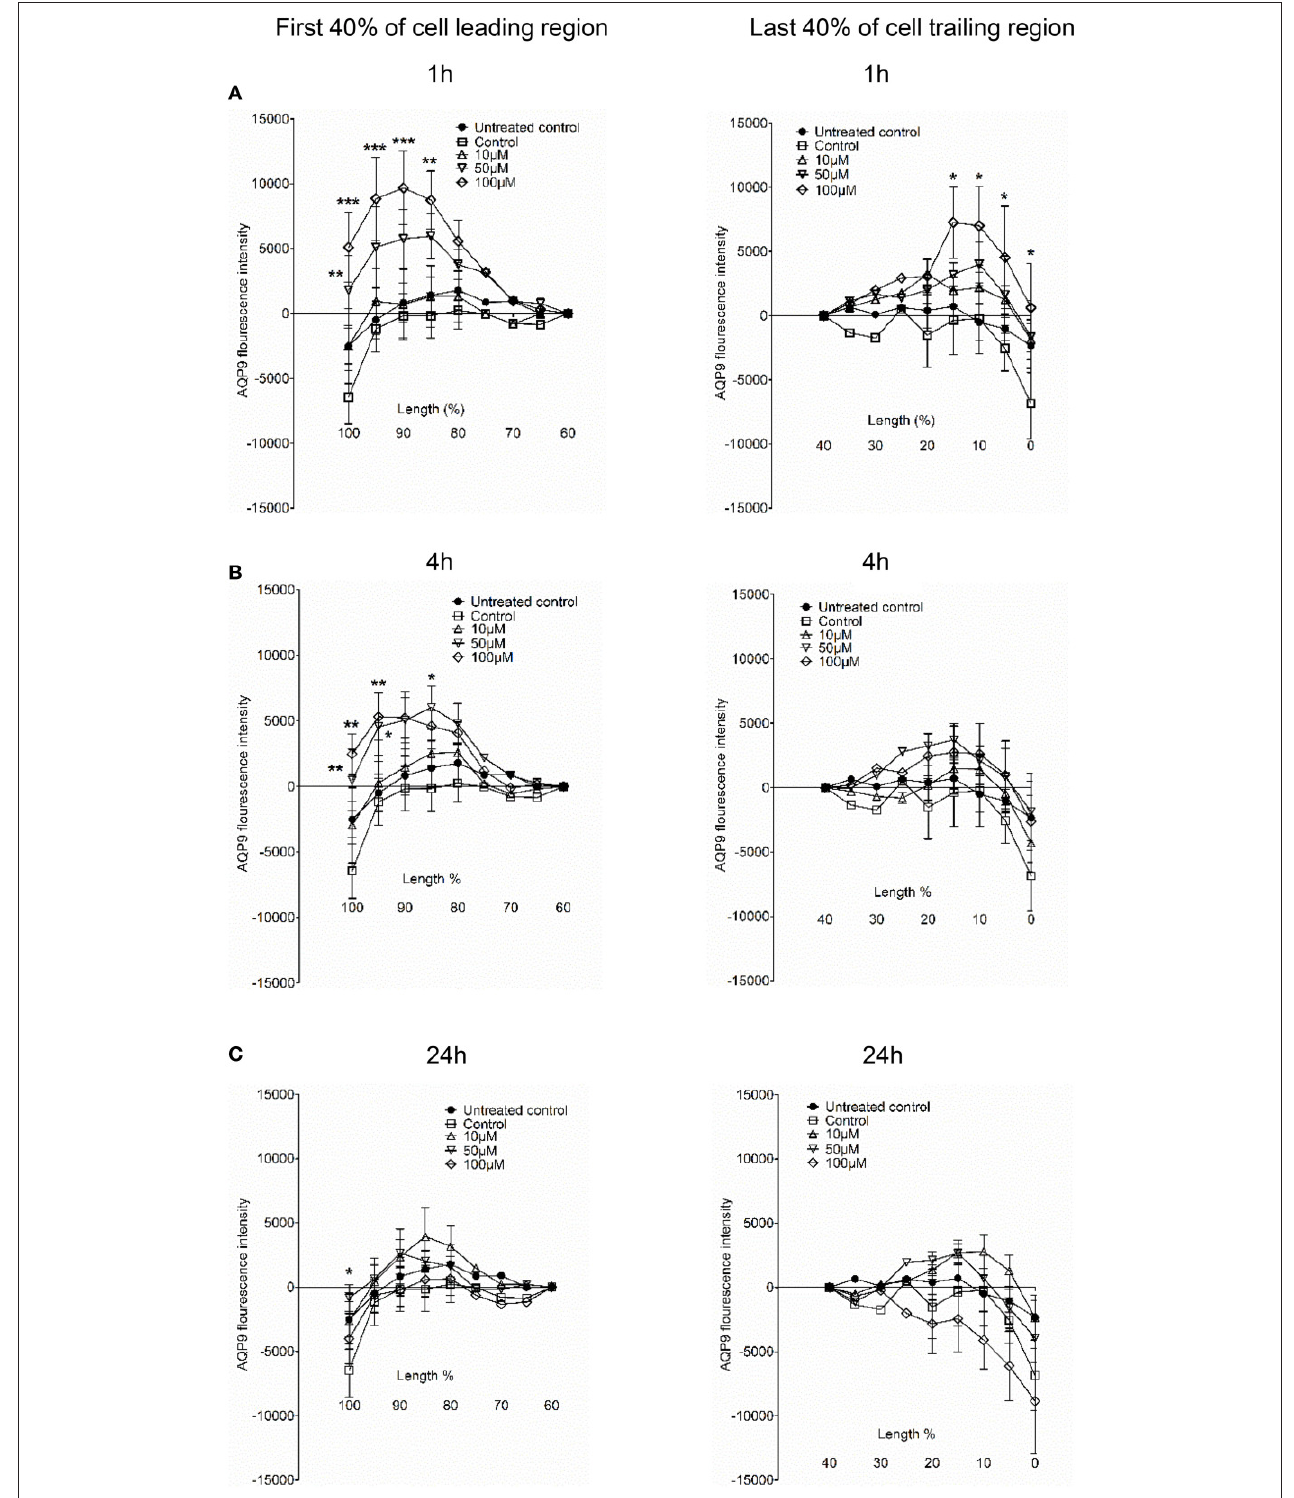
FIGURE 5 | AQP9 intensity profiles across the leading and trailing regions in macrophages. The experiment, measurements and the quantifications of AQP9 intensity profiles over the cell in the direction of polarization were performed as shown by white arrow in Figure 4A . AQP9 intensity difference in the first 40% of cell leading region (left row) and last 40% of cell trailing region (right row) in macrophages after 3O-C 12 -HSL-treatments for 1, 4, and 24h are shown in (A), (B) , and (C) , respectively. Values are the mean ± SE. Significant differences are indicated with * when P < 0.05, ** when P < 0.01, and *** when P < 0.001, as analyzed by one-way ANOVA. Data are from at least 4 different experiments performed on separate days from six different donors, and at least 100 cells in total per condition were analyzed.